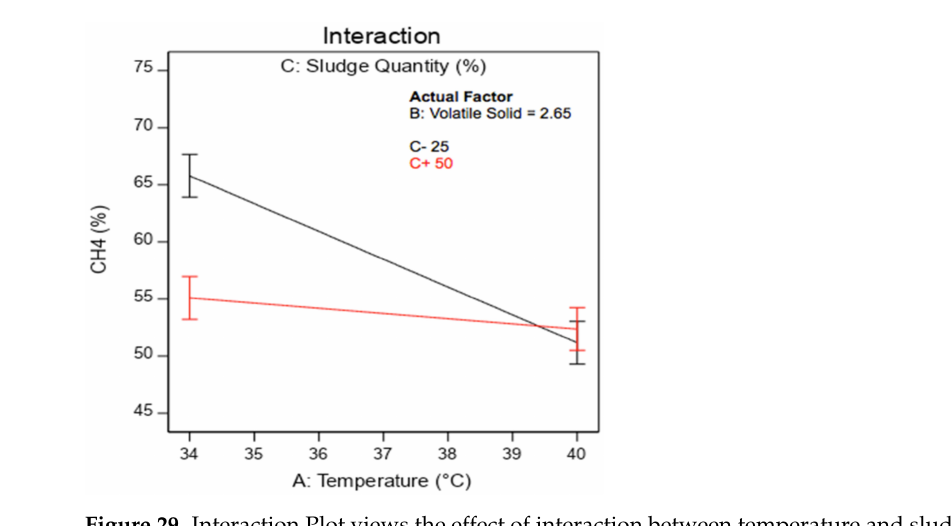
Figure 29. Interaction Plot views the effect of interaction between temperature and sludge quantity on CH 4 percentage.